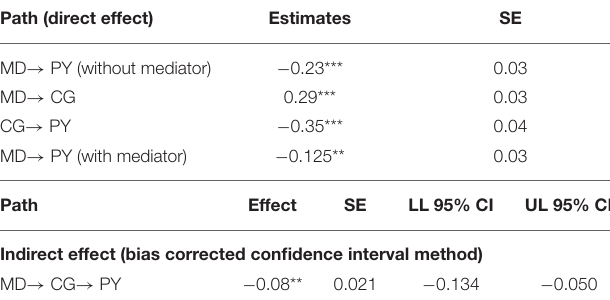
TABLE 4 | Bootstrap results for direct and indirect effects.